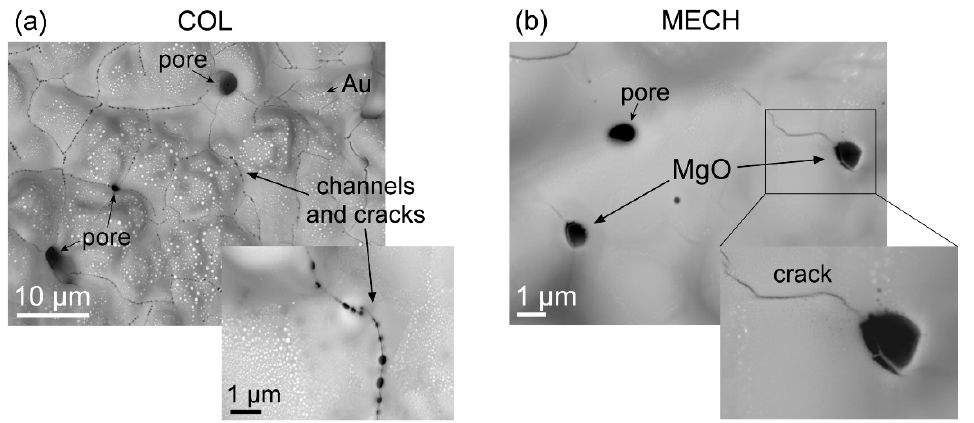
Figure 6. Comparison of Col ( a ) and Mech ( b ) PMN-10PT samples after the dielectric breakdown, viewed along the breakdown path, perpendicular to the sample’s surface. ( a ) The melted surface of the Col sample shows a network of cracks along the channels of numerous electric breakdown paths penetrating the bulk (see inset for small black holes, i.e., channels, connected by cracks). White bubbles are remains of molten Au-electrode. ( b ) The surface at the breakdown point in the Mech sample shows a melted matrix with MgO grains that were cracked. The inset shows the propagation of a crack along the grain boundaries of the matrix that ends at the MgO grain.